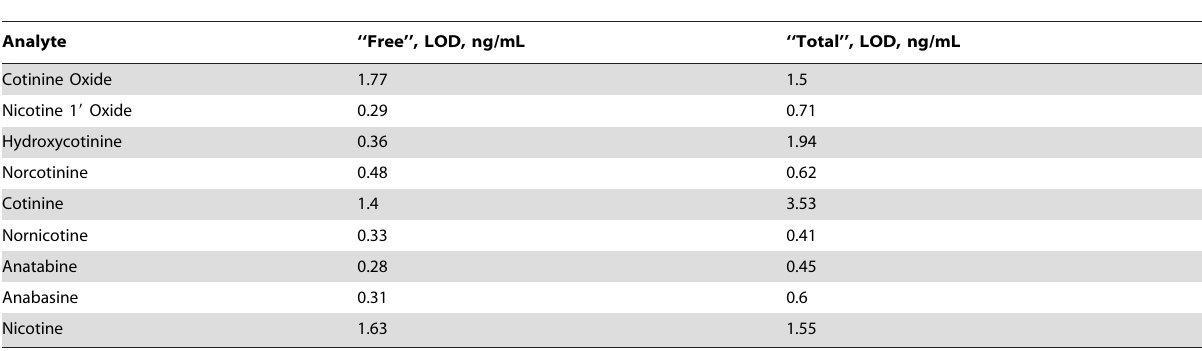
Table 4. Limits of Detection (LOD) for ‘‘free’’ and ’’total’’